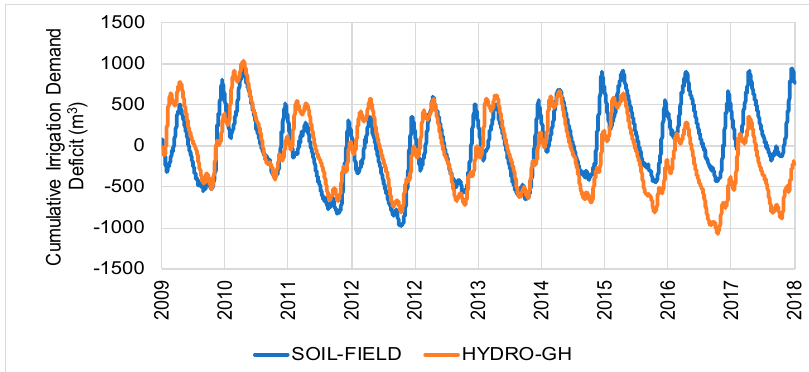
Figure 11. Cumulative difference (VCD) between recirculating aquaculture system effluent supply and irrigation demand in SOIL-FIELD and HYDRO-GH for Parafield climate, Scenario 1 over the ten year simulation.